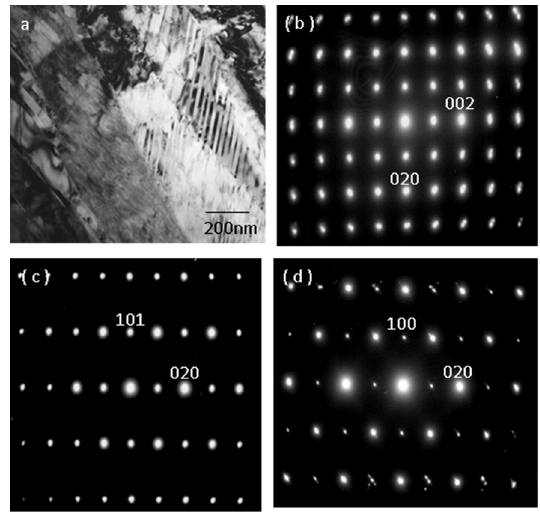
Figure 3. ( a ) TEM bright-field image of the as-annealed Ti 50 Ni 49 W 1 alloy, ( b ) SADP of (a) with [100] M zone axis, ( c ) SADP of (a) with [101] M zone axis, and ( d ) SADP of (a) with [001] M zone axis.